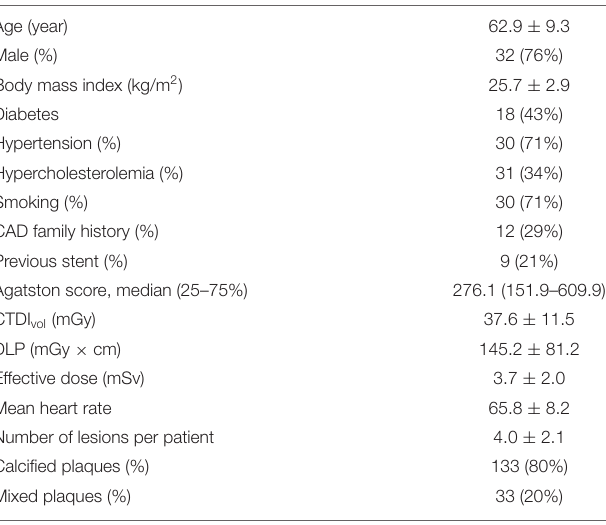
TABLE 1 | Detailed patient baseline characteristics.